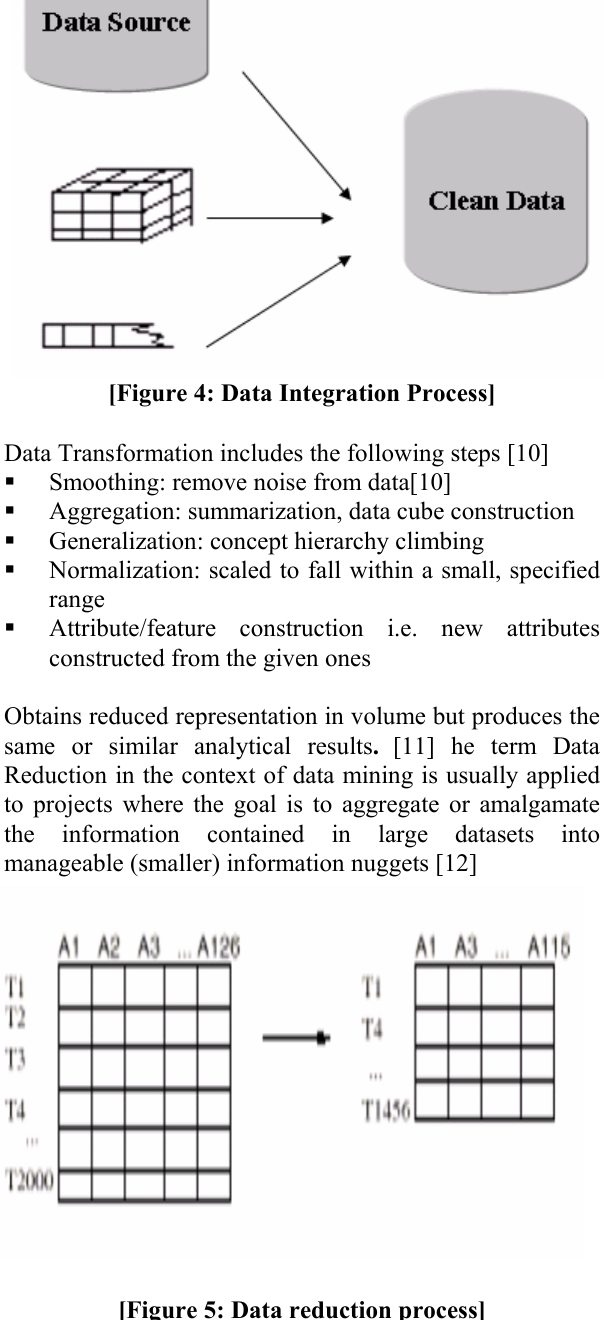
[Figure 6: Un-clustered data]